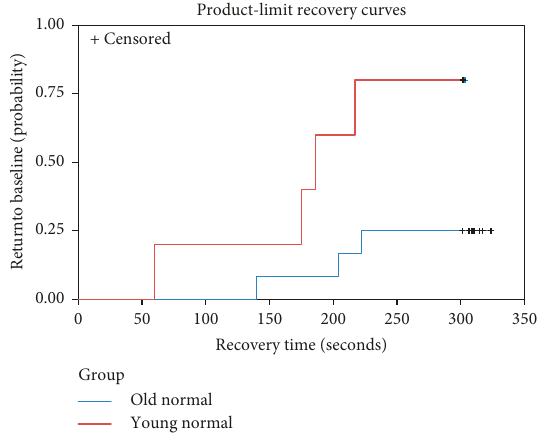
Figure 1: Kaplan–Meier recovery curves for the older group (blue) and the younger group